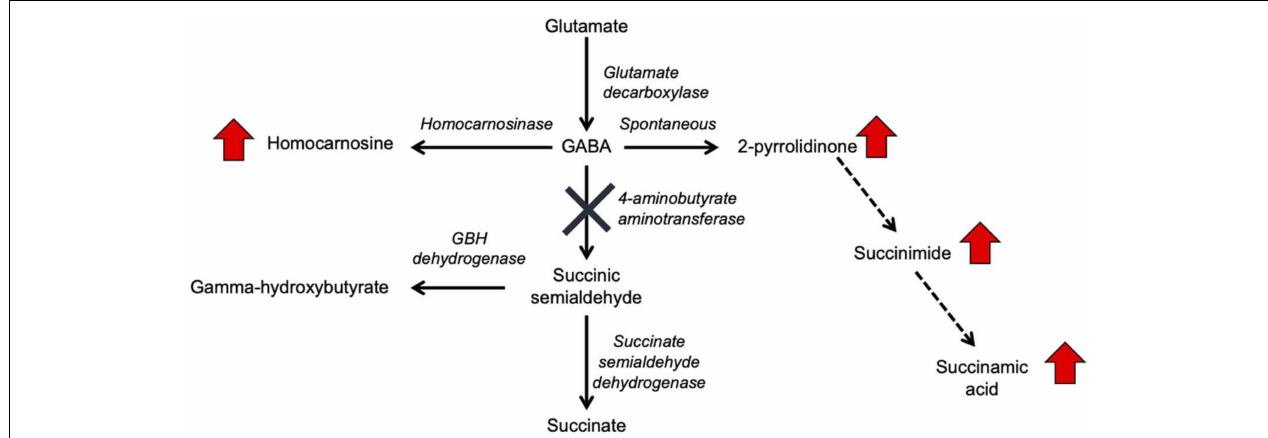
FIGURE 1 | GABA metabolism pathways are altered due to GABA-transaminase deficiency and treatment affecting GABA metabolism. The entire pathway from glutamate conversion to GABA through succinate formation is represented along with the respective enzymes for each step. Due to tissue-specific expression of the enzymes, not all molecules are detected in each biological matrix (e.g., homocarnosine is present below the limit of detection in